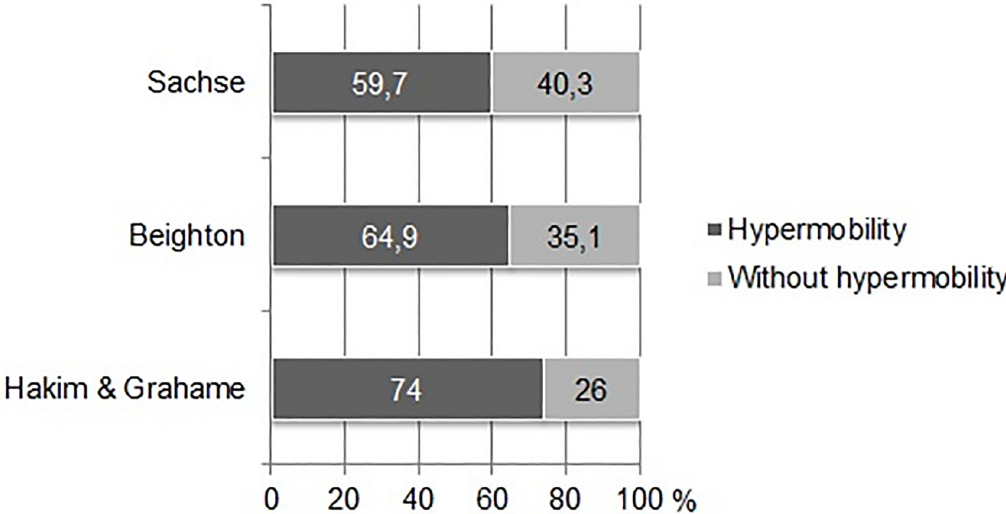
Fig 2. Percentage frequency distribution of JHS prevalence, according to Sachse, Beighton, and Hakim & Grahame.